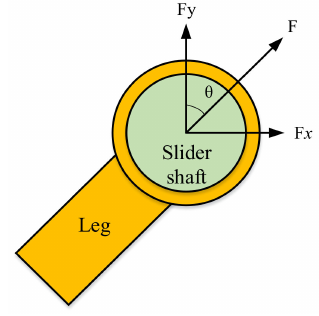
Figure 5. Static analysis at R1